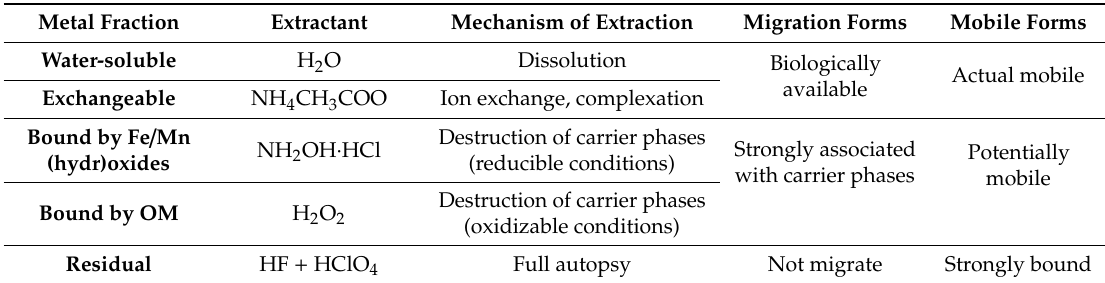
Table 1. Ecological significance of geochemical fractions of metals released during sequential extraction (according to